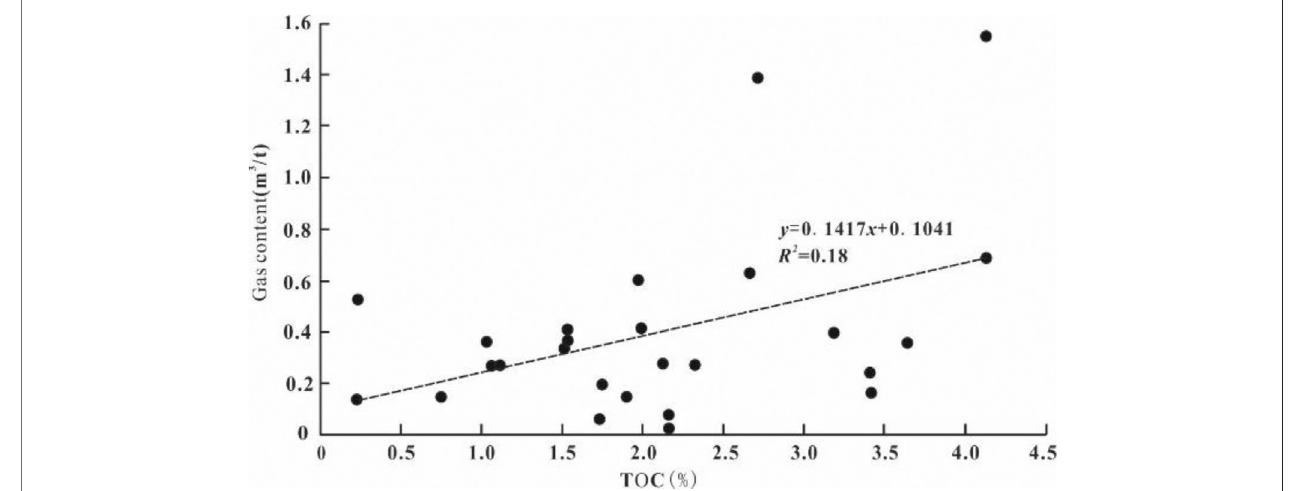
FIGURE 10 | Linear relationship model between the gas content and the TOC in the coal-bearing areas of southwestern Shandong Province.